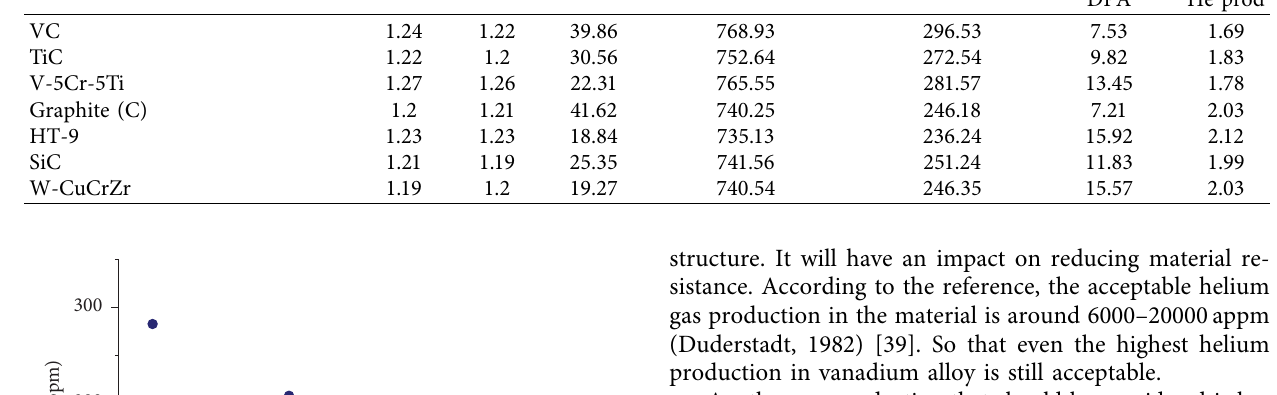
Table 4: Neutronic performance and radiation damage efect in seven material candidates of the frst wall. Material candidates for frst wall